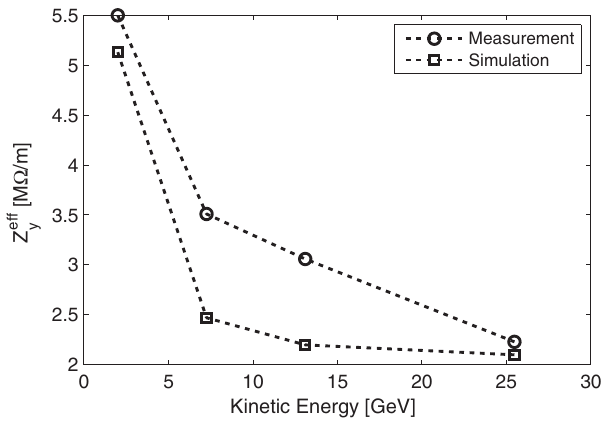
FIG. 11. Imaginary part of the effective vertical impedance computed from tune shift measurements and from the impedance model, as a function of energy.